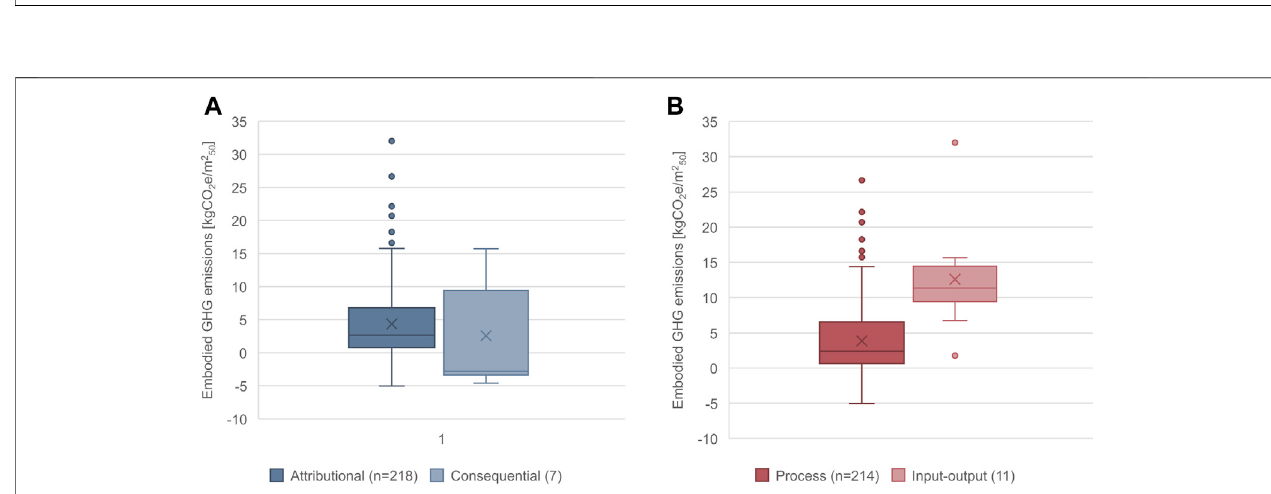
FIGURE5| EmbodiedGHGemissionsdistributedonLCAmethod (A) andLCImodelling (B) .Thedotsintheplotindicatetheoutliersofthedataset.Theboxesand the linewithin the boxes indicate the quartiles of the dataset (25 percentile, 50 percentile (median) and 75percentile). The x indicates the average. The error bars outside the boxes indicate the deviation in the